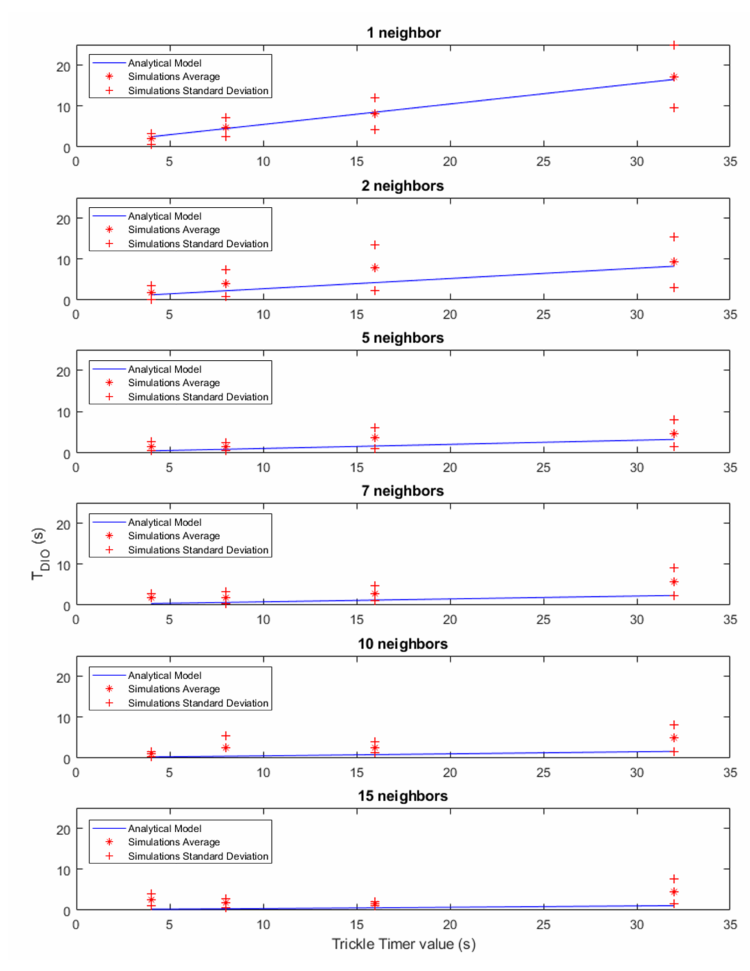
Figure 5. RPL simulation